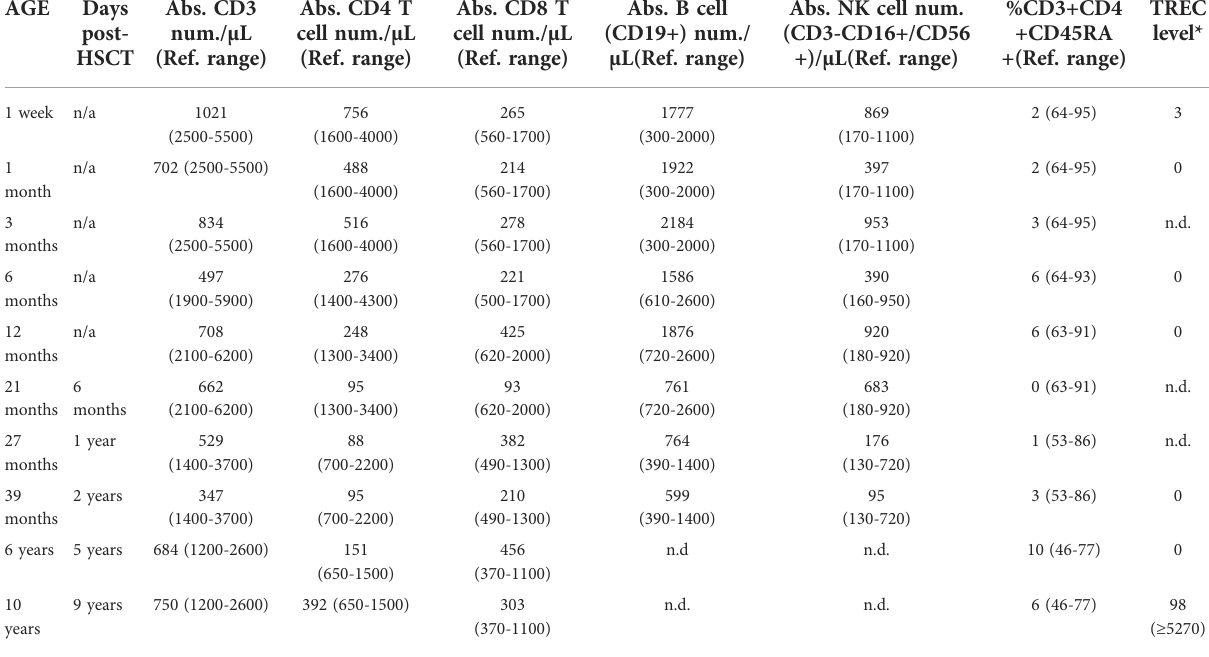
TREC level assayed by two methods: through newborn screening laboratory with blood fi lter card and liquid blood sample through CLIA laboratory, n/a, not applicable. n.d., not done. Reference ranges